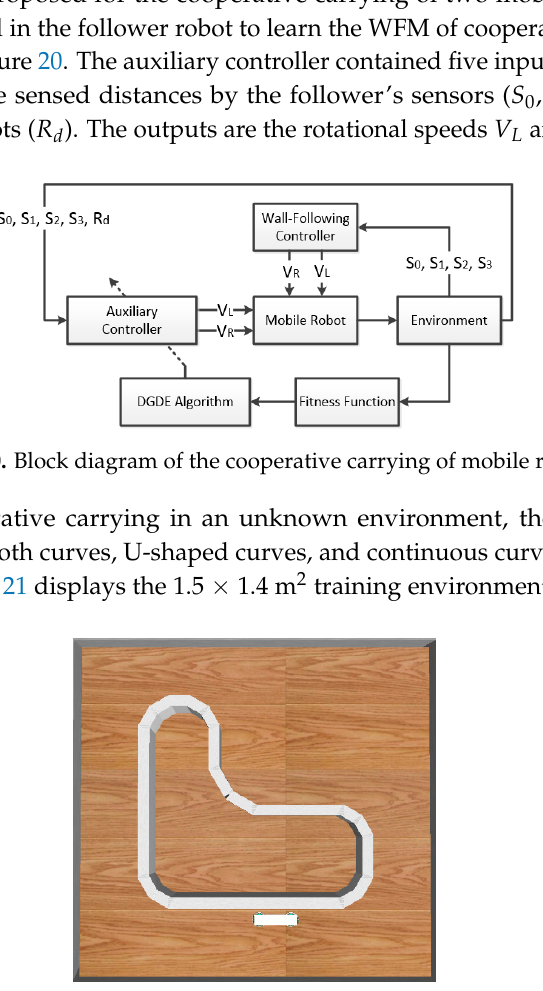
Figure 19. Cooperative carrying of two mobile robots.